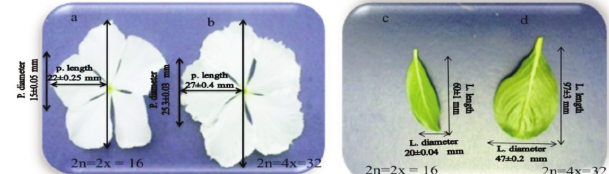
Fig. 5 - Size of diploid petal (a), size of tetraploid petal (b), size of diploid leaf (c) and size of tetraploid leaf (d) in diploid and tetraploid genotypes of C. roseus